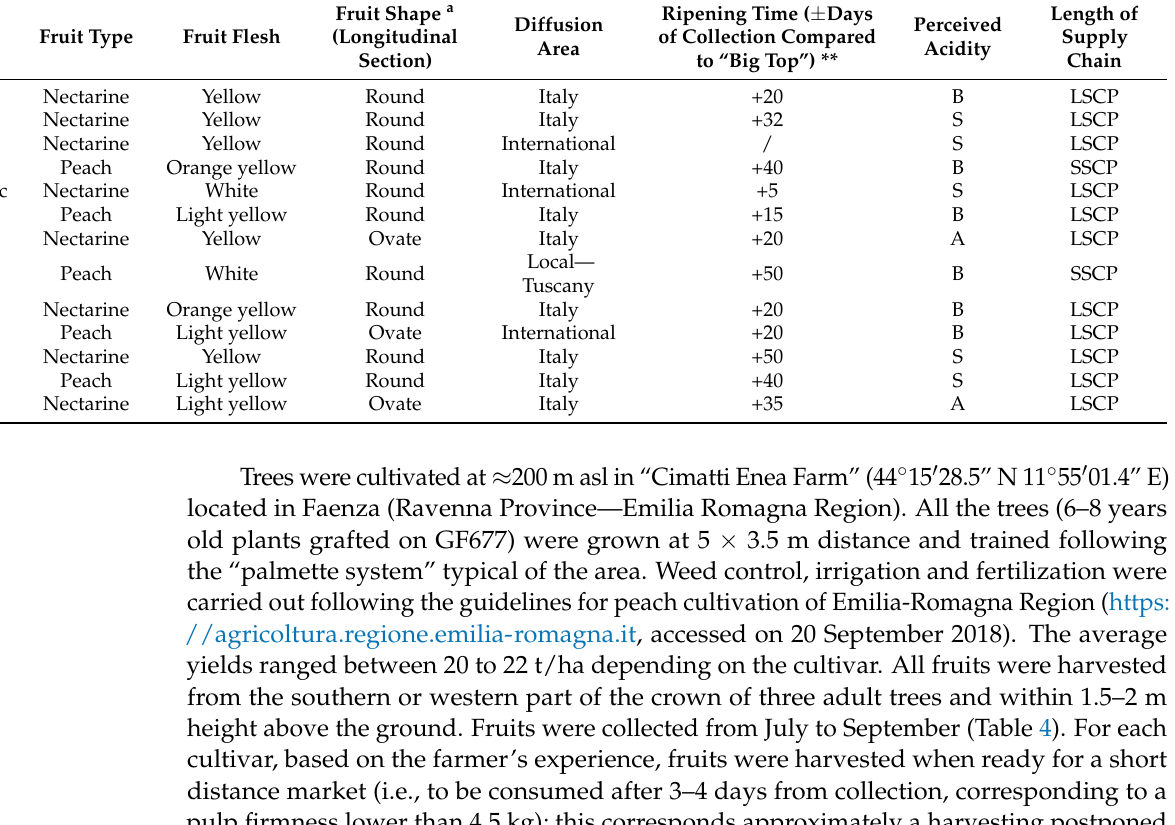
Table 4. General information: fruit type, fruit flesh color, fruit shape, diffusion area ( a Descriptor list for Peach (ECPGR Priority Descriptors for Peach [44])), ripening time (** “Big Top” fruits are collected in Faenza (Bologna, Emilia Romagna, Italy) at 5 July), Length of Supply Chain (LSC has been defined: Long ~25 days of shelf life under storage condition; Short ~3 days of shelf life under storage condition), and Perceived Acidity (PA has been defined as: S = Subacid (with acidity below 70 meq/L), B = Balanced (acidity between 70 and 130 meq/L), A = Acidic (acidity above 130 meq/L) [43].